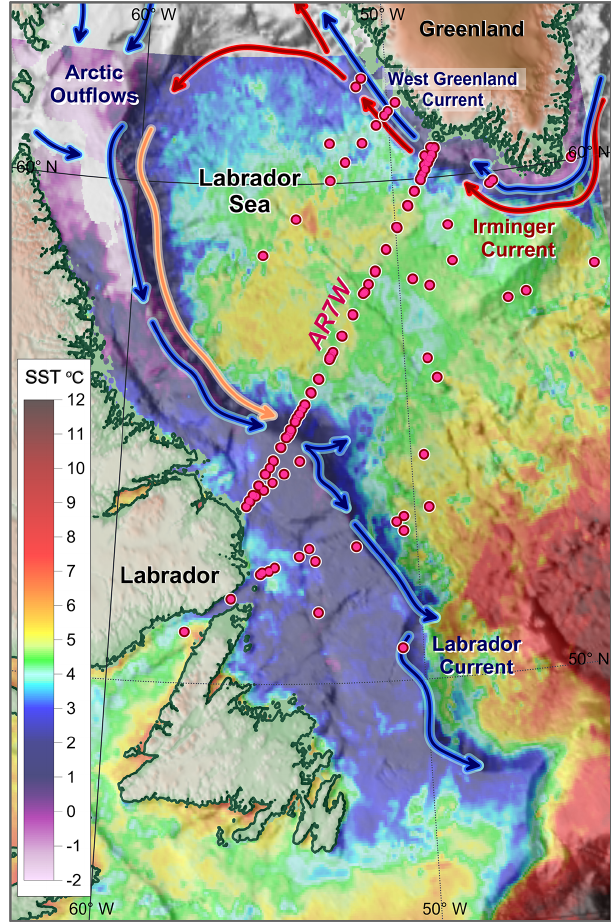
Figure 1. Map showing stations along the AR7W transect and addi- tional stations sampled during late spring and early summer (2005– 2014). The station positions are superimposed on a composite im- age of sea surface temperature for the last 3 weeks of May 2006 collected by the NOAA satellite (AVHRR). White patches represent ice (Labrador and Greenland coasts). Circulation elements – colder currents (Labrador Current, Arctic outflows, and West Greenland Current, blue solid arrows), warmer currents (Irminger Current (IC) and extension, dark red and light solid arrows, respectively). The extended branch of the IC is a modified (cooled and freshened) wa- ter mass caused by lateral and vertical mixing along the Labrador